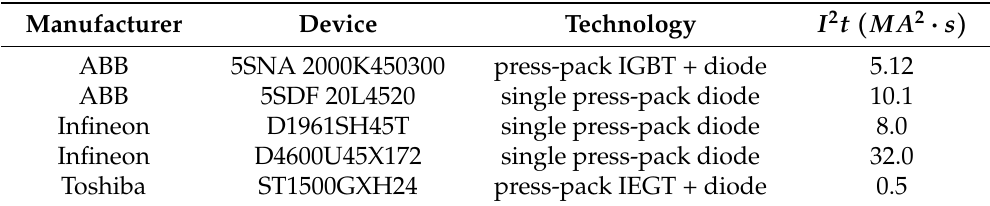
Table 9. Surge current integral ( MA 2 · s ) for typical 4.5 kV devices.